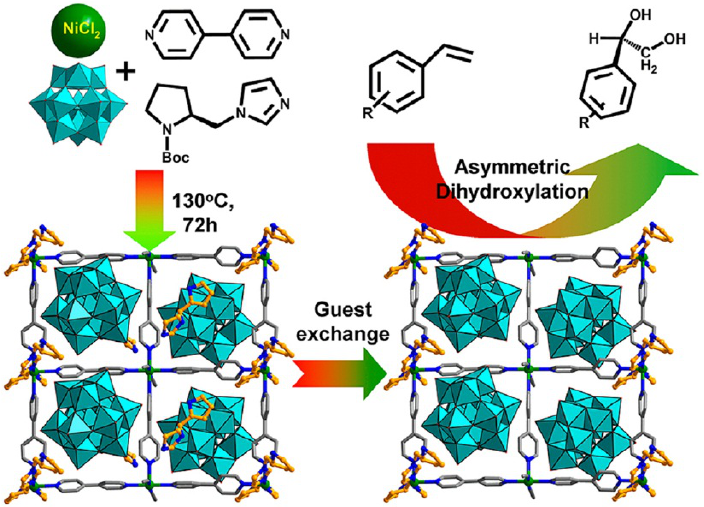
Figure 14. Synthetic procedure of NI-PYI1, showing the guest exchange and the potential amphipathic channel for the asymmetric olefin dihydroxylation. Reproduced with permission from ACS, 2013